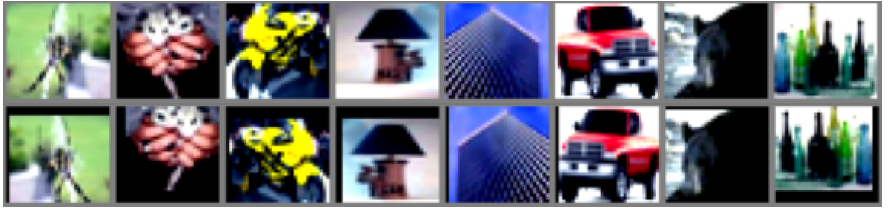
Figure 3. The typical images from the CIRFAR-100 dataset. ( Top ): original image. ( Bottom ): augmented image. The labels from left to right: spider, possum, motorcycle, lamp, skyscraper, pickup truck, bear, and bottle.